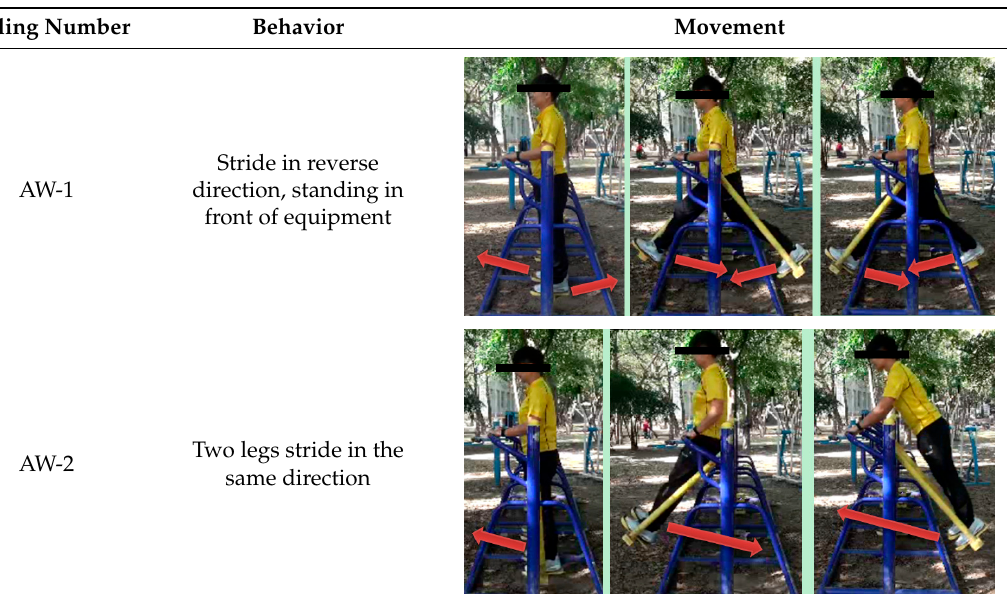
Table A2. Depictions of user behaviors for the air